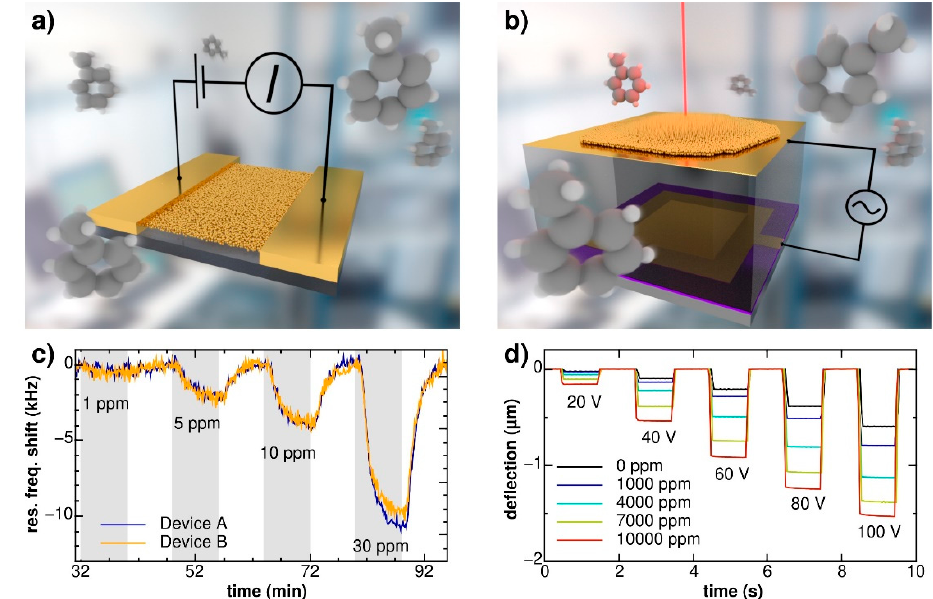
Figure 1. ( a ) Schematic depiction of a GNP composite film based chemiresistor; ( b ) Schematic depiction of a GNP membrane based microelectromechanical chemical sensor; ( c ) Frequency transients of GNP/6DT membrane based microelectromechanical chemical sensors under exposure to toluene vapors of different concentrations. The membrane edge lengths, thicknesses and fundamental resonance frequencies are 80 µm/60 µm, 46 nm/48 nm and ~450 kHz/~350 kHz for devices A/B, respectively; ( d ) Quasi-static deflection transients of an electrostatically actuated GNP membrane based microelectromechanical chemical sensor under exposure to varying toluene concentrations (membrane edge length 100 µm, thickness 39 nm) [13]. The experiments described in c and d were conducted under ambient pressure nitrogen